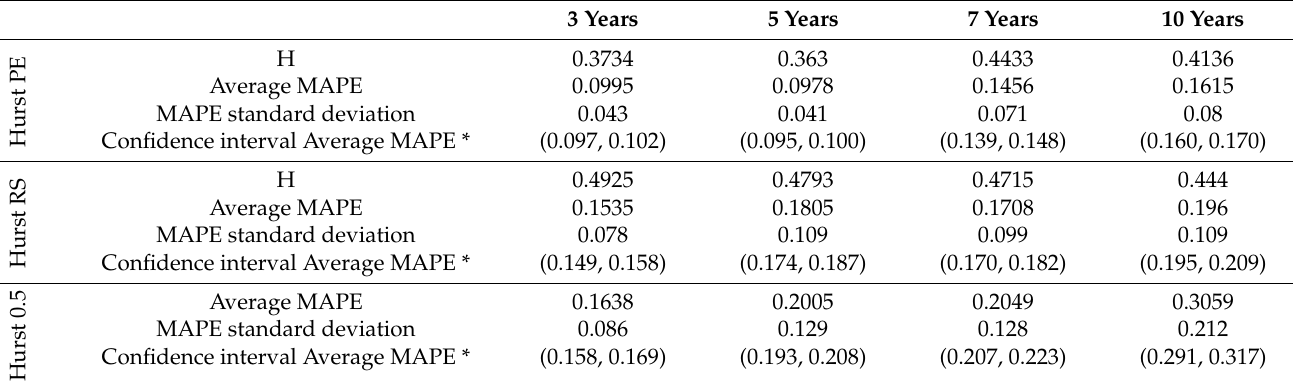
Table 2. Hurst exponent and MAPE results for the S&P 500.